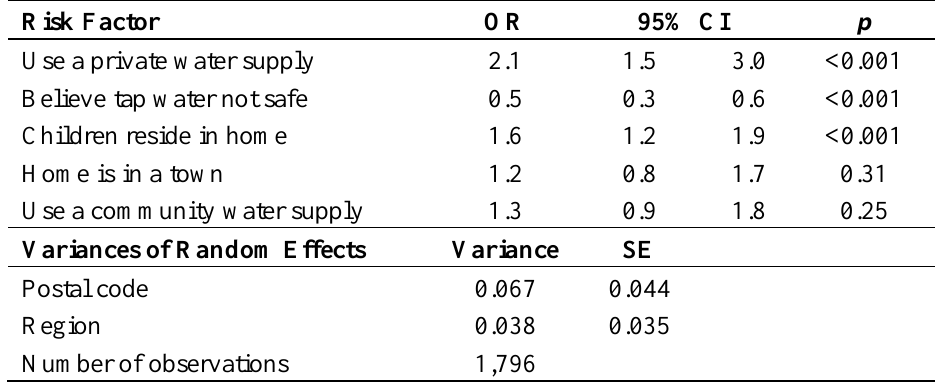
Table 5. Risk factors included in final multivariable model for in-home treatment of tap